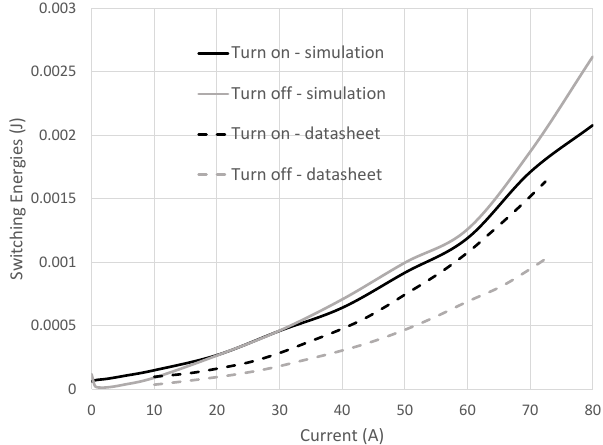
Figure 3. Comparison of the energy curves obtained by simulation and the curves disclosed in the datasheet of the device SCT3030AL. Conditions: V gs = 18 V/0 V, V ds = 400 V, R G = 0 Ω .